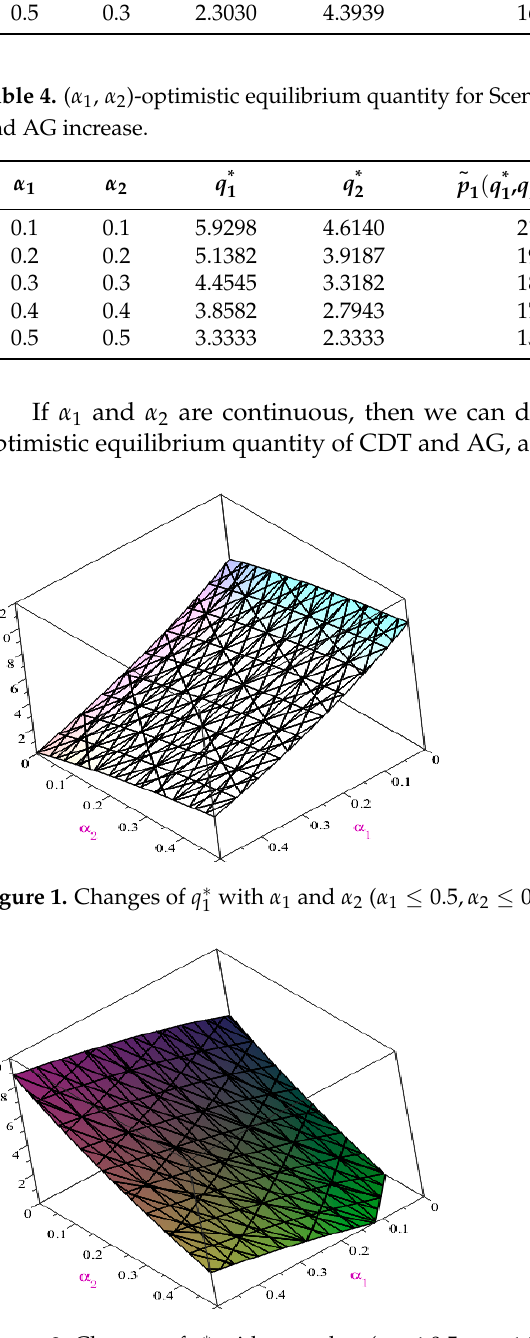
Figure 2. Changes of q